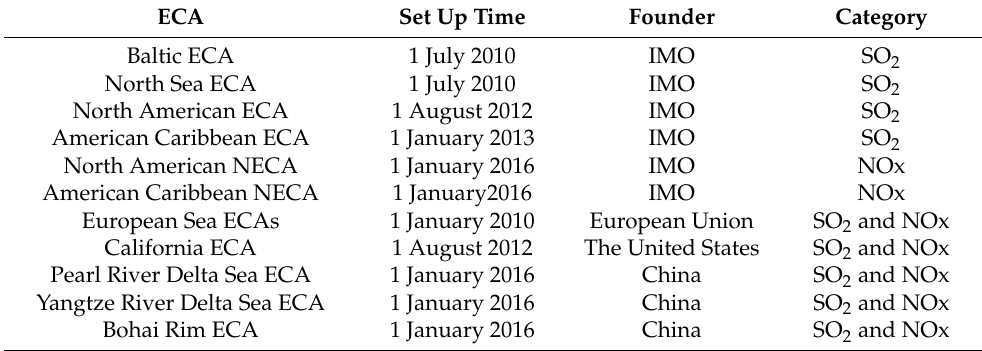
Table 2. ECA information.